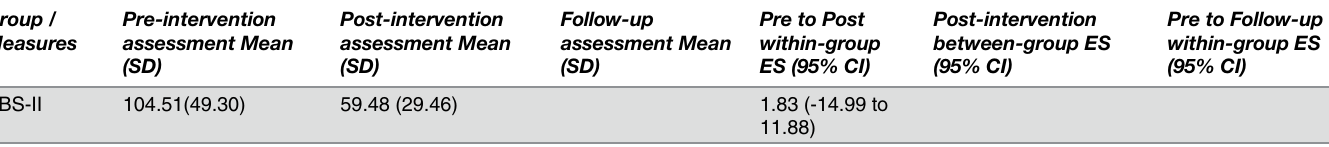
Abbreviations: LSAS-SR = Liebowitz Social Anxiety Scale – Self-Report version; SPIN = Social Phobia Inventory; SIAS = Social Interaction and Anxiety Scale; SPSQ = Social Phobia Screening Questionnaire; BDI-II = Beck Depression Inventory-II; ATQ = Automatic Thoughts Questionnaire; ABS-II = Attitude and Belief Scale-II.ES = Effect size; WLCG = wait list control group. Note: For the fi rst three columns the values represent the self-report mean and (SD = standard deviation), while for the last three columns the values represent the ES and (95% CI = con fi dence interval).